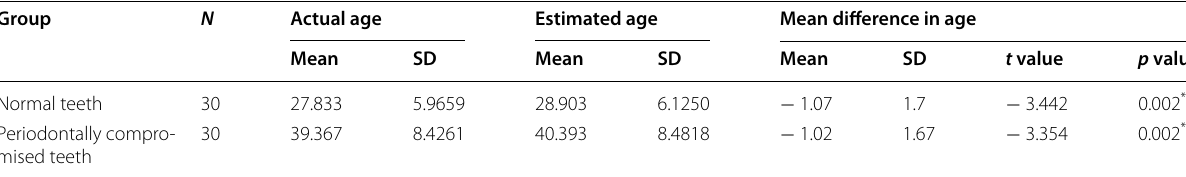
** Statistically highly significant ( p <0.01)